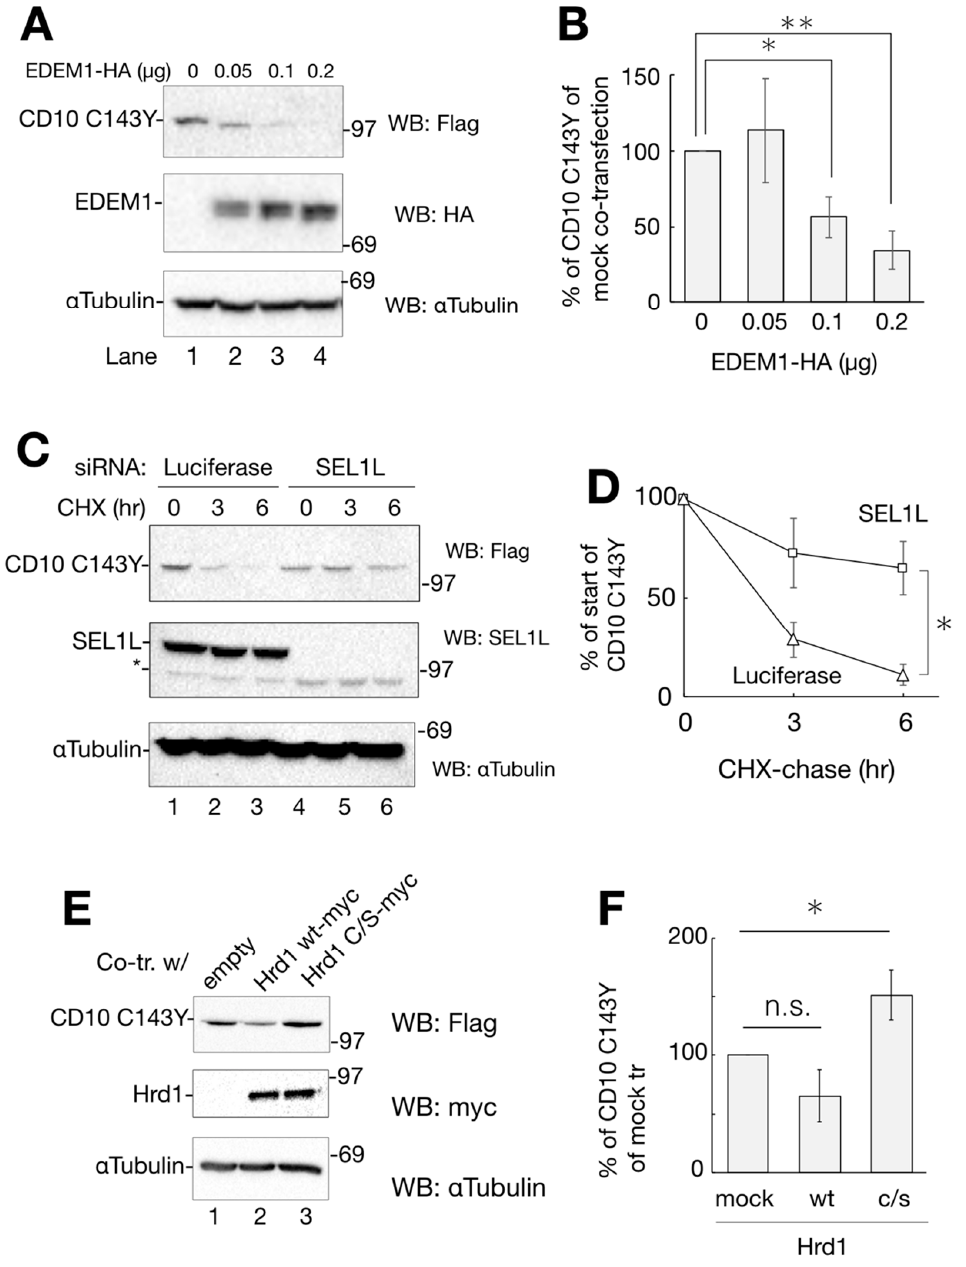
Figure 5. Degradation of CD10 C143Y through ER-associated degradation (ERAD) . ( A ) overexpression of EDEM1-HA enhances CD10 C143Y clearance. Co-transfected HeLa cells with CD10 C143Y-Flag nd EDEM1-HA (lanes 1–4; 0, 0.1, 0.15, 0.2 µ g, respectively) were subjected to Western blotting with